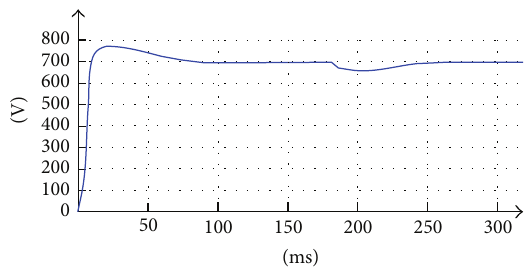
Figure5: DynamicresponsewaveofDCbusvoltage(load changes).